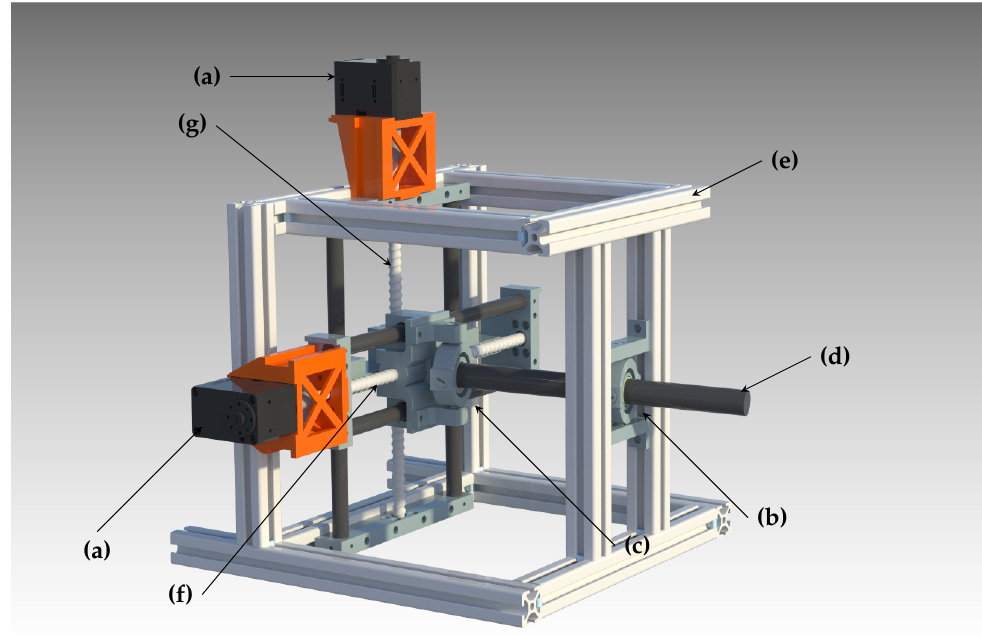
Figure 4. Full system CAD: ( a ) Dynamixel servo motors; ( b ) frontal universal joint with linear sliding bearing; ( c ) second universal joint; ( d ) central lever shaft and sensor mounting point; ( e ) system frame; ( f ) XY-Table pan axis and ball screw; ( g ) XY-Table tilt axis and ball